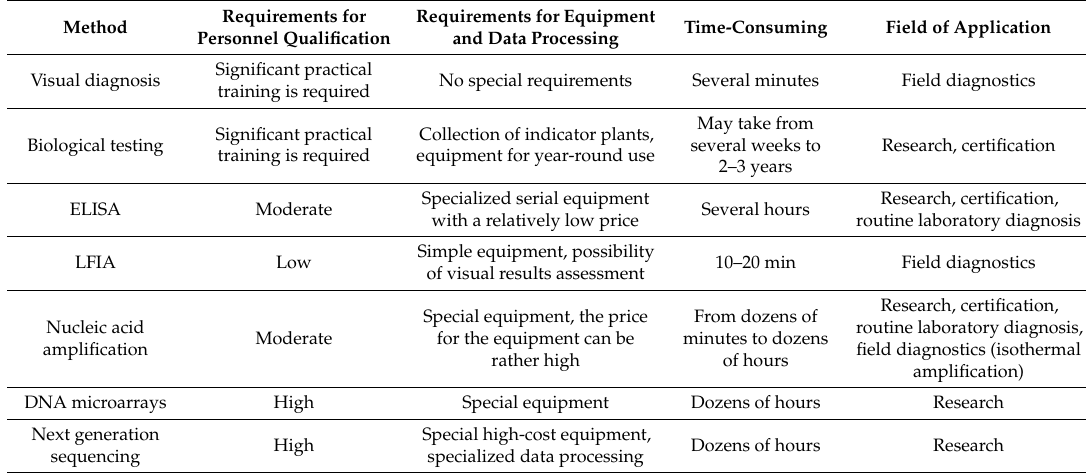
Table 2. Summary of the methods used for grapevine virus detection.